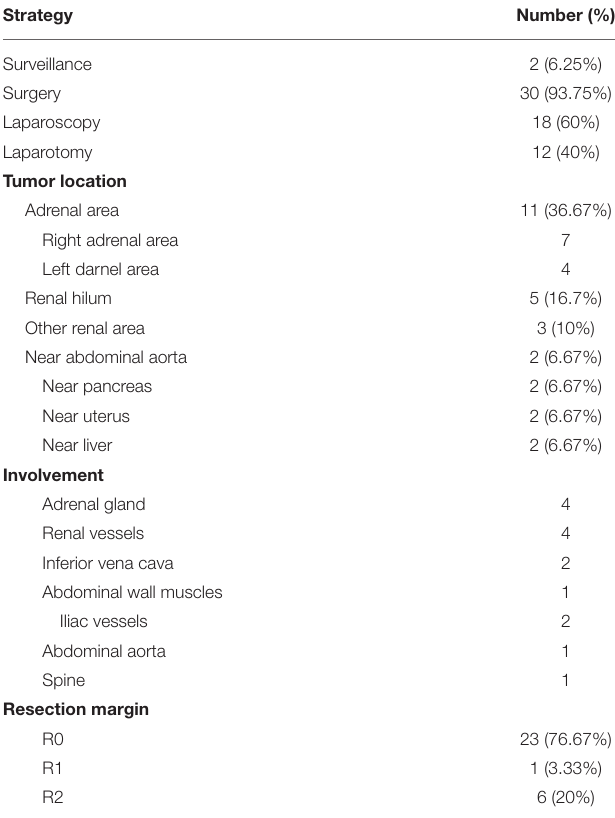
TABLE 4 | Treatment of 32 cases with retroperitoneal